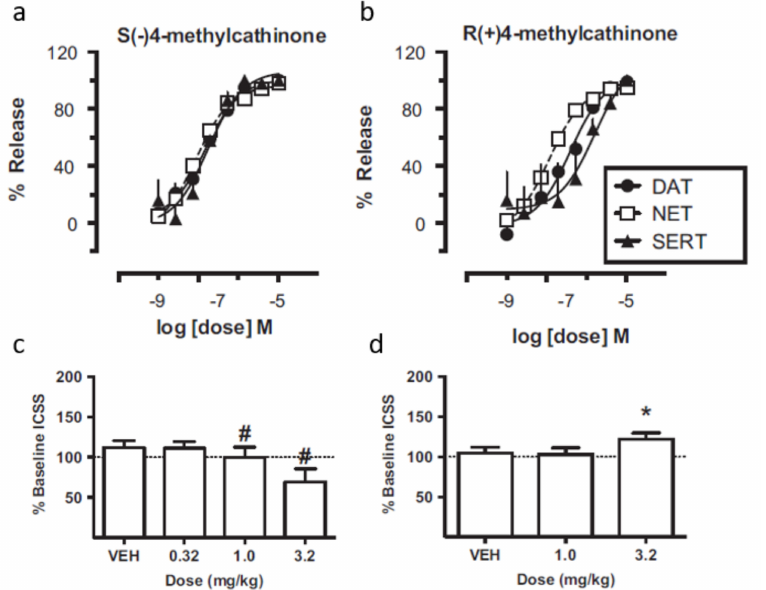
Figure 13. Effects of S -( − )4-methylcathinone and R -(+)-4methylcathinone on monoamine release via DAT, SERT and NET (( a ) and ( b ), respectively) and on ICSS (( c ) and ( d ), respectively) [59]. DAT: dopamine transporters; NET: norepinephrine transporters; SERT: serotonin transporters; ICSS: intracranial self-stimulation. * indicate significant increases and # indicated significant decreases in ICSS rates relative to vehicle for at least one stimulation frequency as determined by analysis of frequency–rate curves in panels ( a , b ).